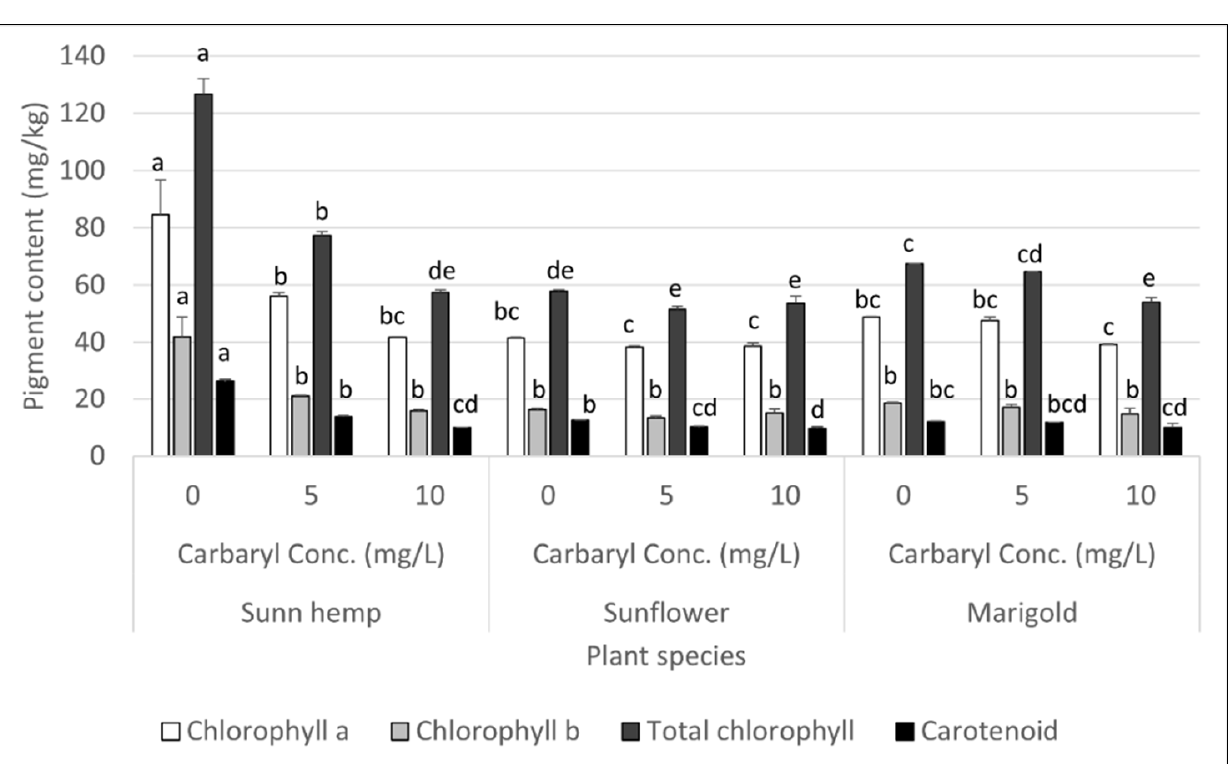
Figure 4. Effect of carbaryl on pigment contents of plants after 4 days of cultivation for carbaryl treatments at 0, 5 or 10 mg L − 1 . Note: a, b, c, d, and e indicate significant differences based on ANOVA and Tukey’s HSD test. The data shown are mean and SD.